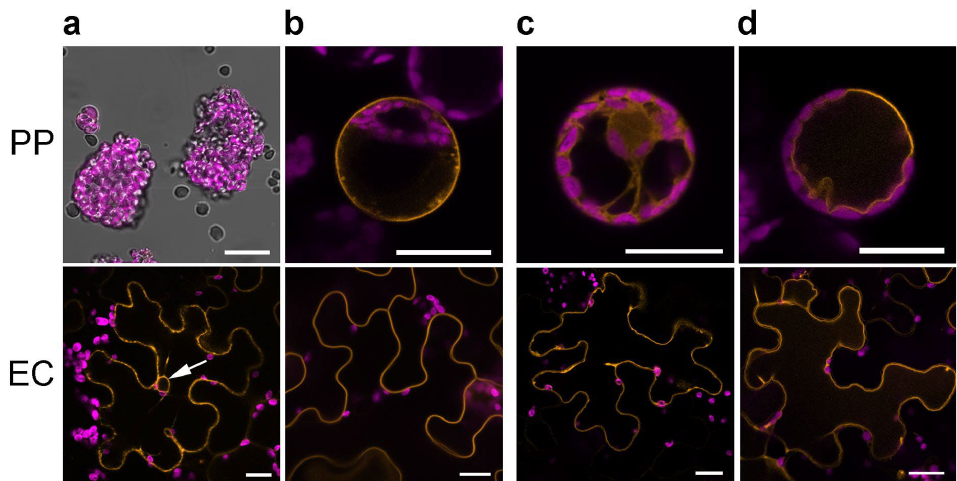
Figure 2. Subcellular localization of proteins located in plasma membrane ( a , b ) and tonoplast ( c , d ). ( a ) PIP2A–mCherry; note the collapse of mesophyll protoplasts after transformation with the construct encoding PIP2A, whereas it labels also the endomembrane system in epidermal leaf cells (arrow). To visualize the collapsed protoplasts, the bright-field image was added. ( b ) mCherry–LTIP6B; the plasma membrane is clearly labeled in both protoplast and epidermal cells. ( c ) VHA-E1–mCherry; although tonoplast appears to be labelled in epidermal cells, the orange fluorescence appears diffuse within mesophyll protoplasts. ( d ) CDF1–mCherry; transformation with CDF1::mCherry resulted in a strong label at the vacuole membrane. Fluorescence of the protein fusion with mCherry is shown in orange, whereas the autofluorescence of chloroplasts is depicted in magenta. PP—protoplast, EC—epidermal cell. Bars represent 20 µm in all micrographs.